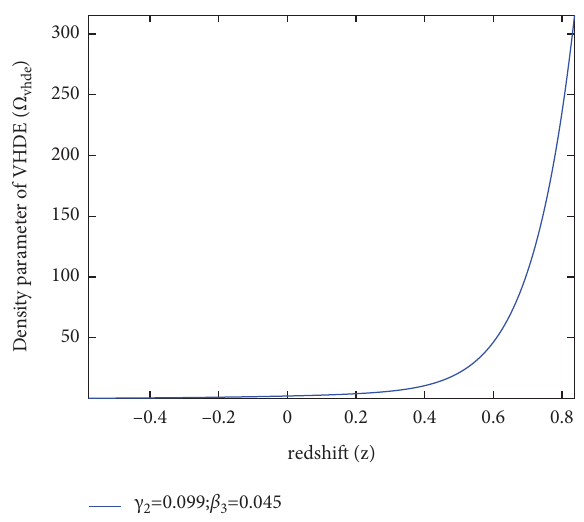
) . versus redshift ( z ) for BT- s